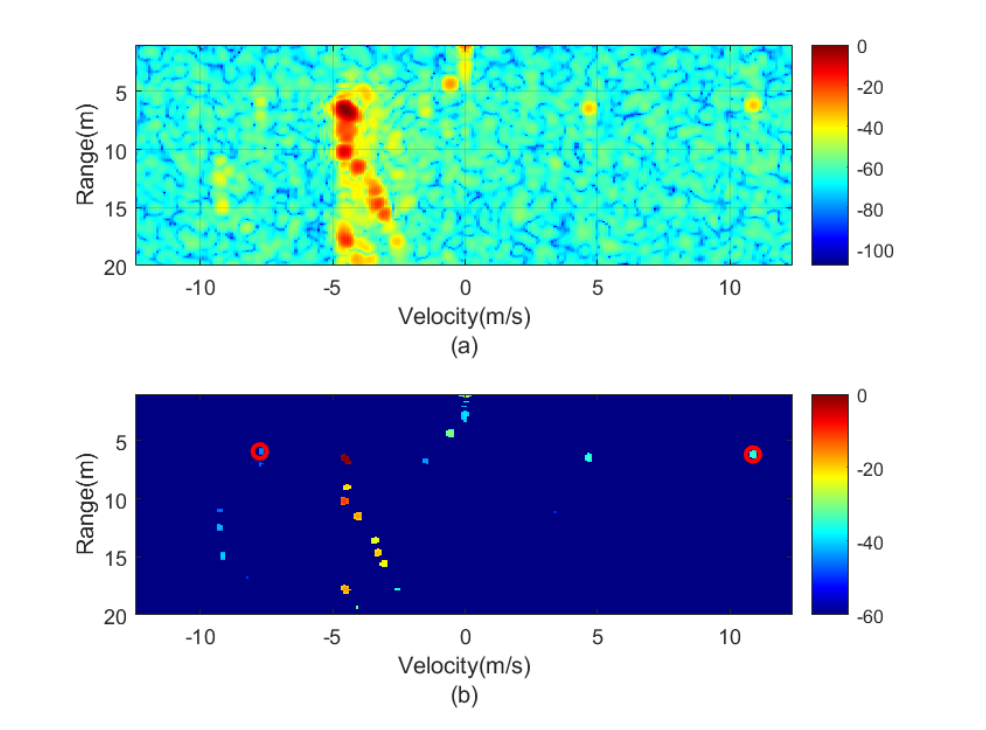
Figure 14. Measured range—Doppler map ( a ) and detection after CFAR processor ( b ) for the transponder modulated at 1000 Hz for a distance of about 18 m.